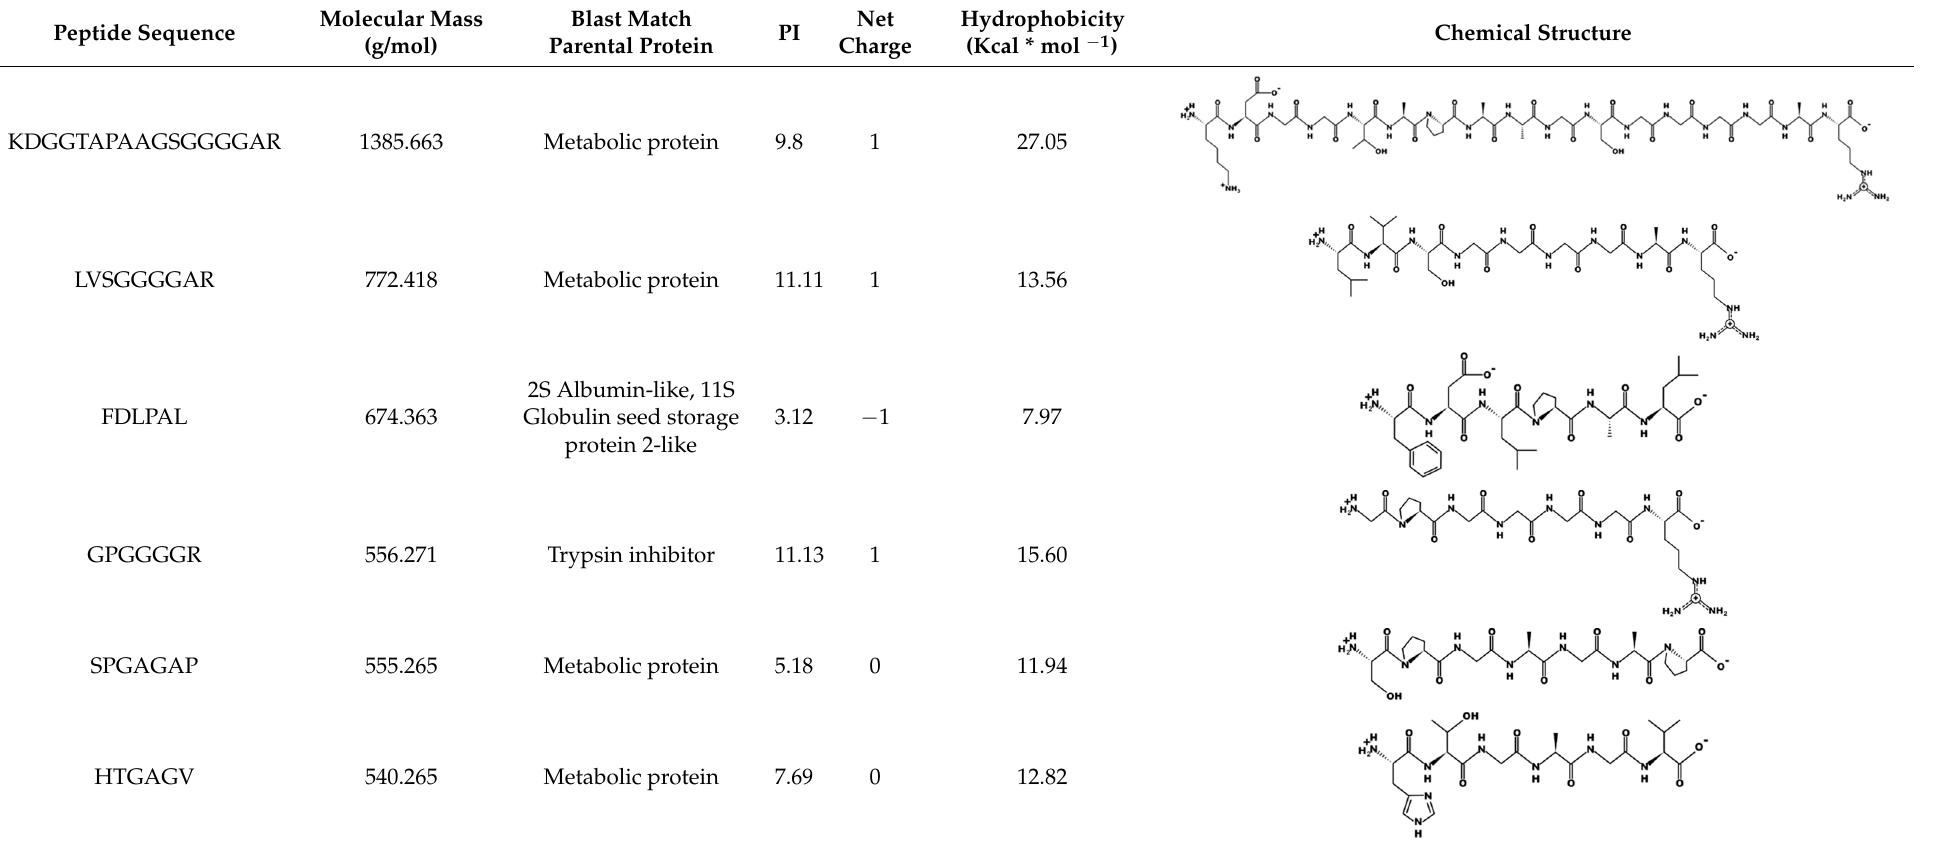
Table 1. Peptides sequences determined by LC-ESI-MSMS from optimized chickpea hydrolysate with in silico potential DPPIV inhibitory activity obtained from isolated protein using bromelain + .